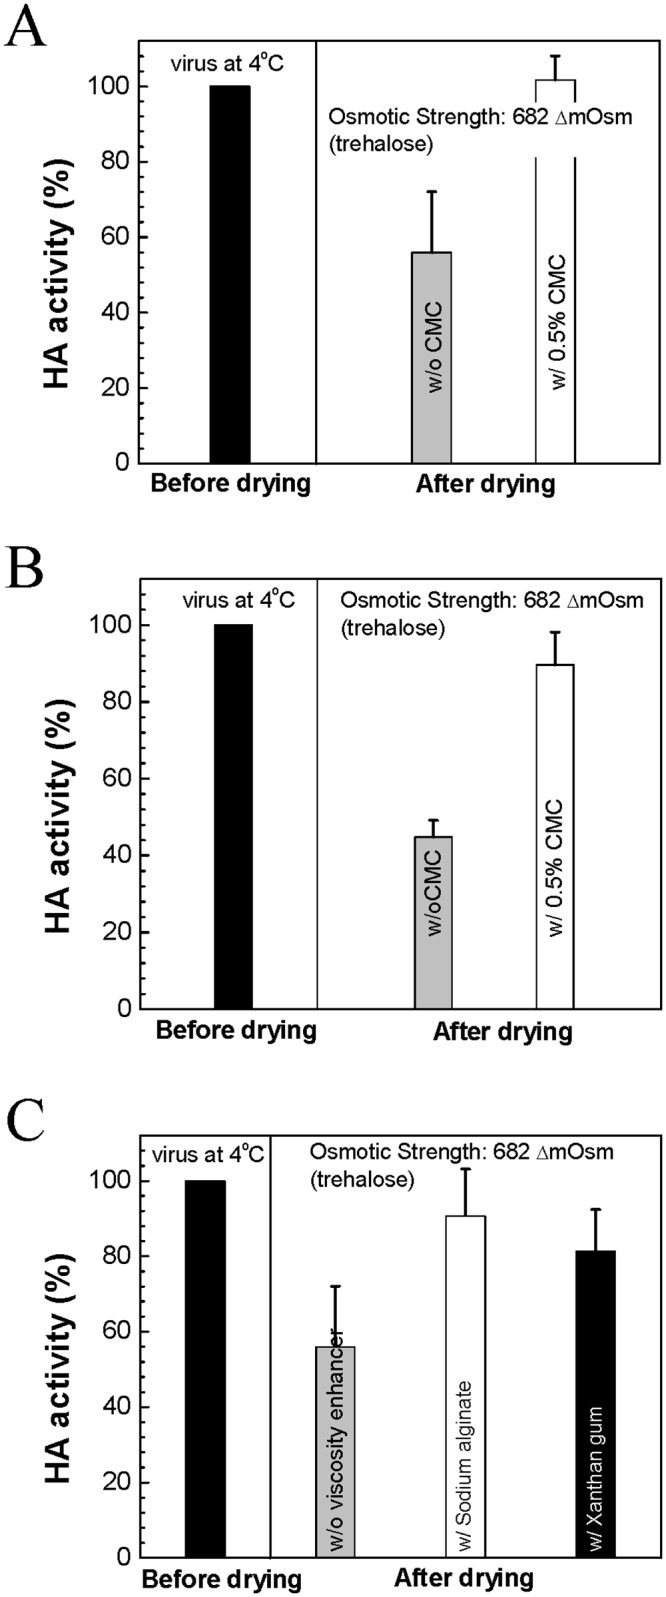
Effects of viscosity enhancer on the HA activity of influenza virus after drying.(A) Inactivated virus, (B
) live virus, and (C) inactivated virus (mean ± SD, n = 8–16). In (C), HA activity of w/o viscosity enhancer was reused from (A) for better comparison.